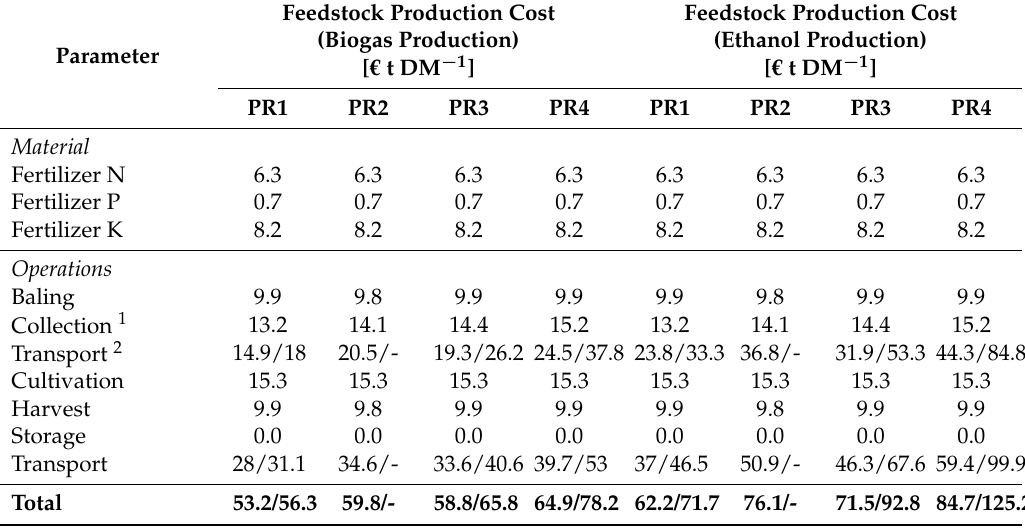
Table A9. Feedstock production costs for winter wheat straw in the different production regions (PR) for the production of biogas and ethanol, when removing amounts of straw according to fraction 3 and fractions